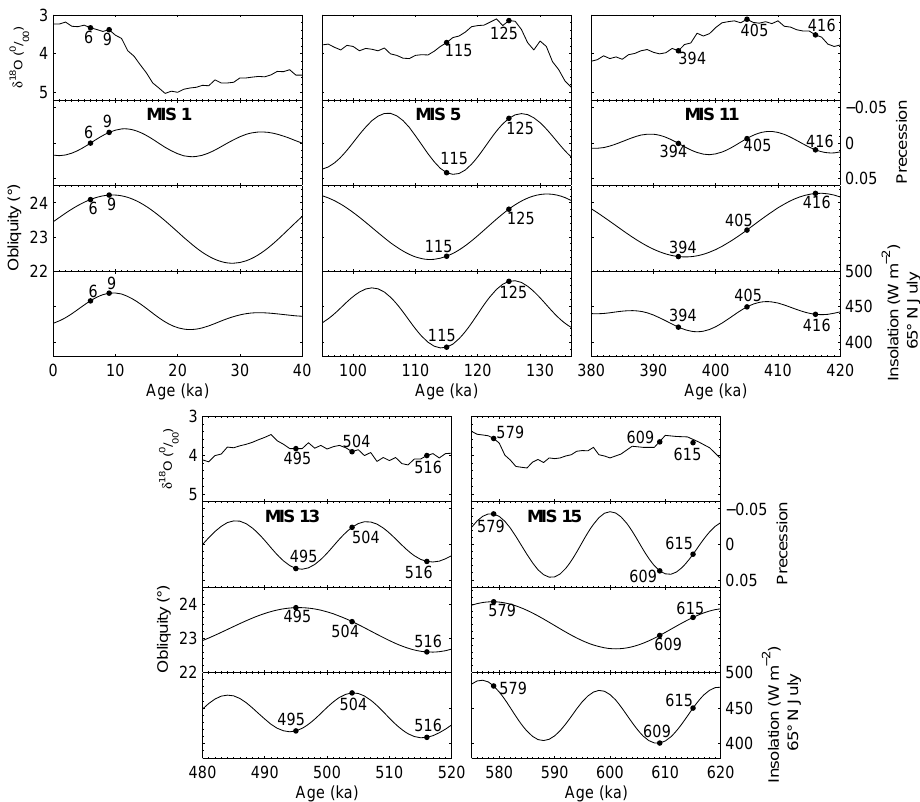
Figure 1. Benthic δ 18 O stack (Lisiecki and Raymo, 2005), climatic precession, obliquity, and insolation in July at 65 ◦ N (Berger, 1978) for the different interglacials. The dots mark the time slices simulated in this